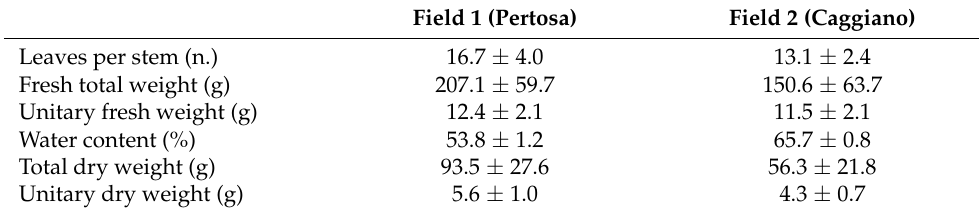
Table 3. Measurements of artichoke senescent leaves 1 .